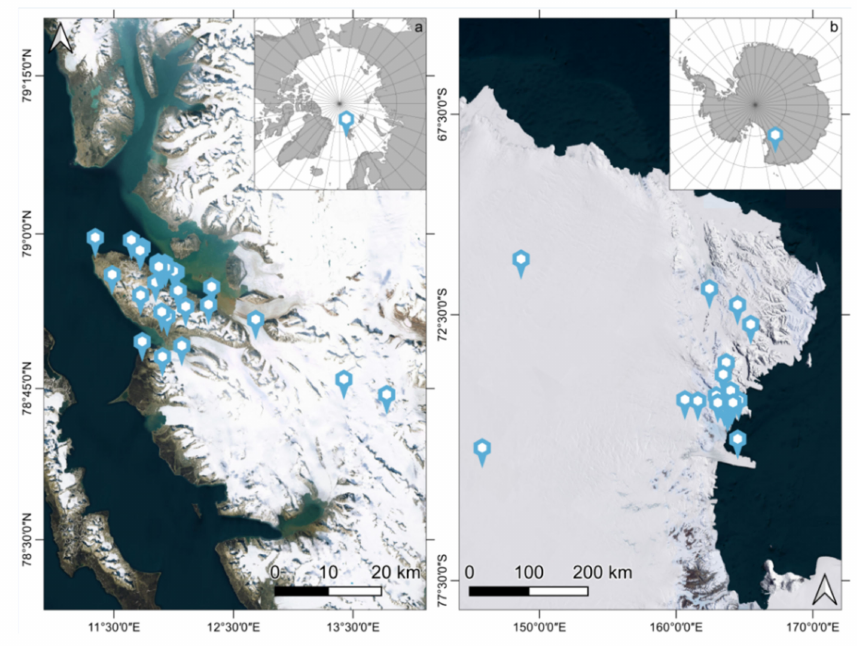
Figure 1. Localization of the available measurement sites in the Arctic region ( a ) and in the Antarctic continent ( b